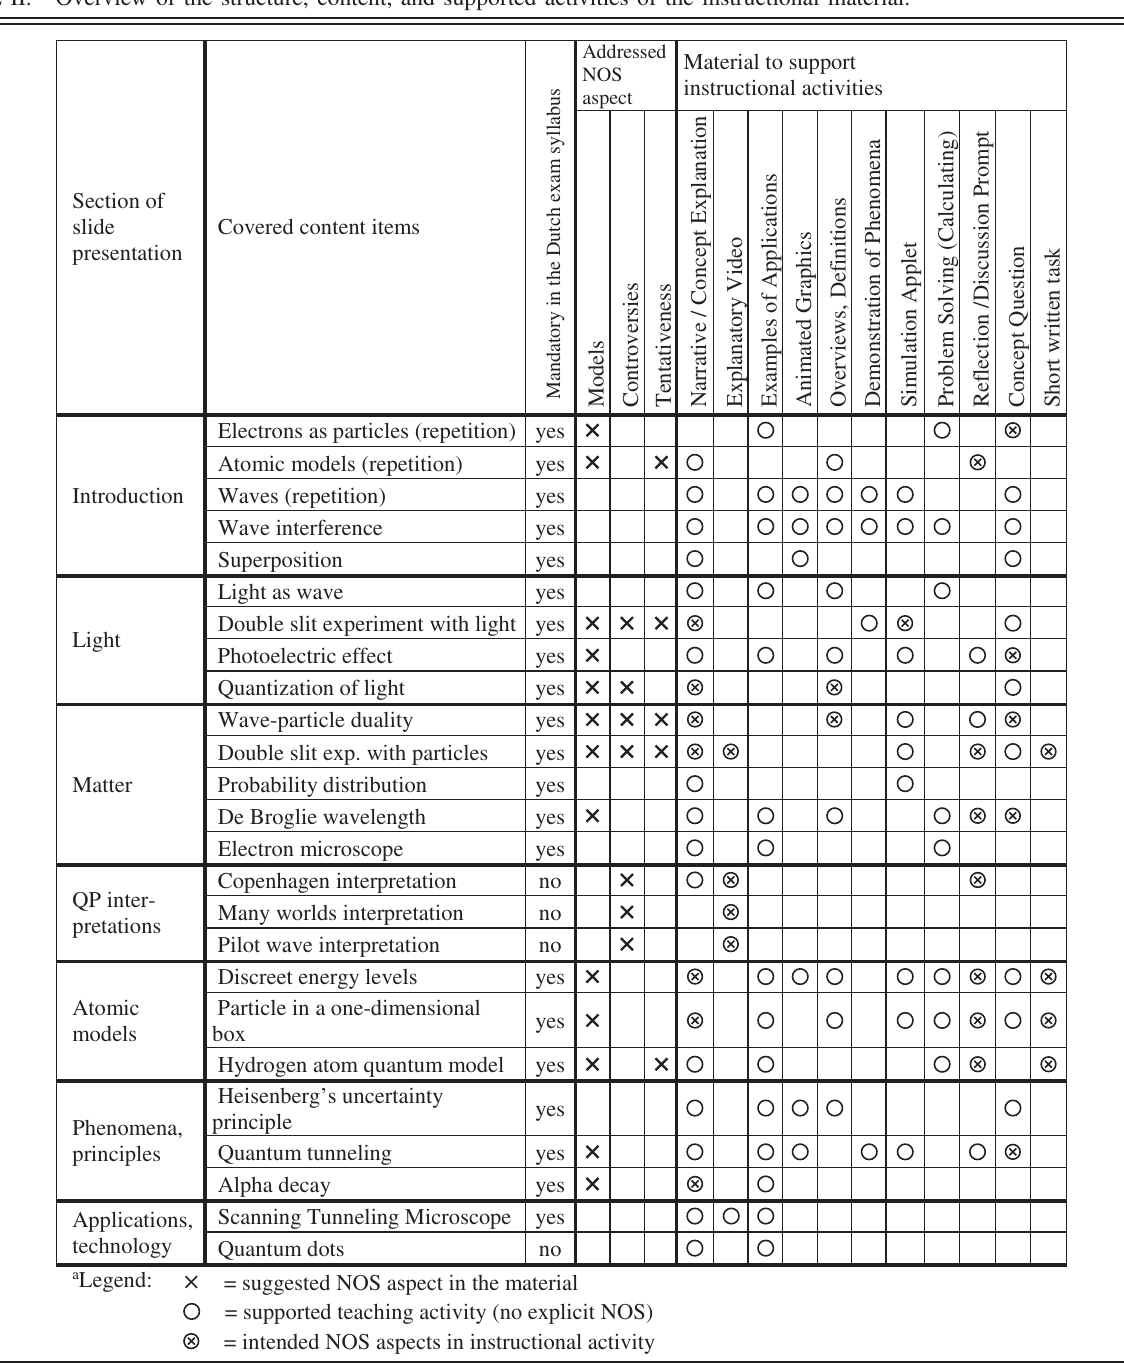
TABLE II. Overview of the structure, content, and supported activities of the instructional material.